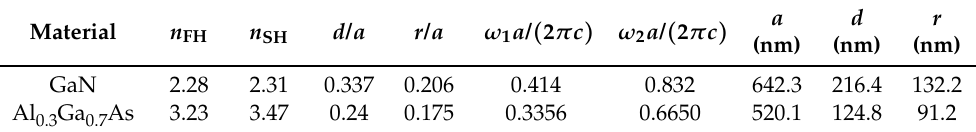
Table 1. Main design parameters of the GaN and Al 0.3 Ga 0.7 As photonic crystal (PhC) slabs obtained with the PSO algorithm applied to a 3D-FDTD